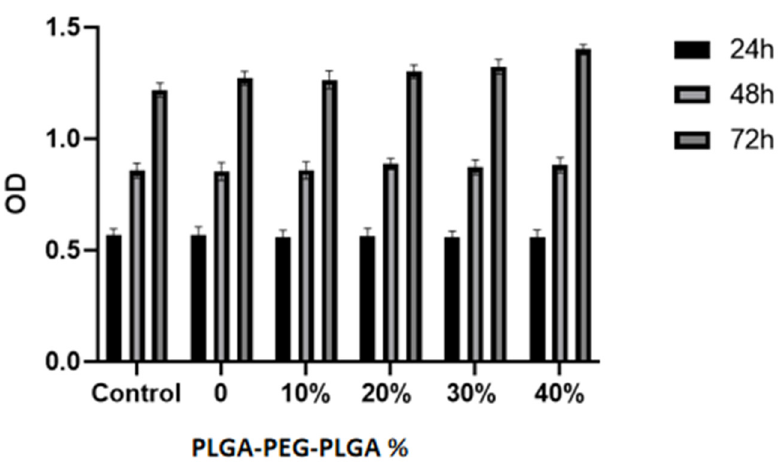
Figure 9. Cytocompatibility of the composite bone cements with different PLGA-PEG-PLGA ther- mosensitive hydrogel contents.